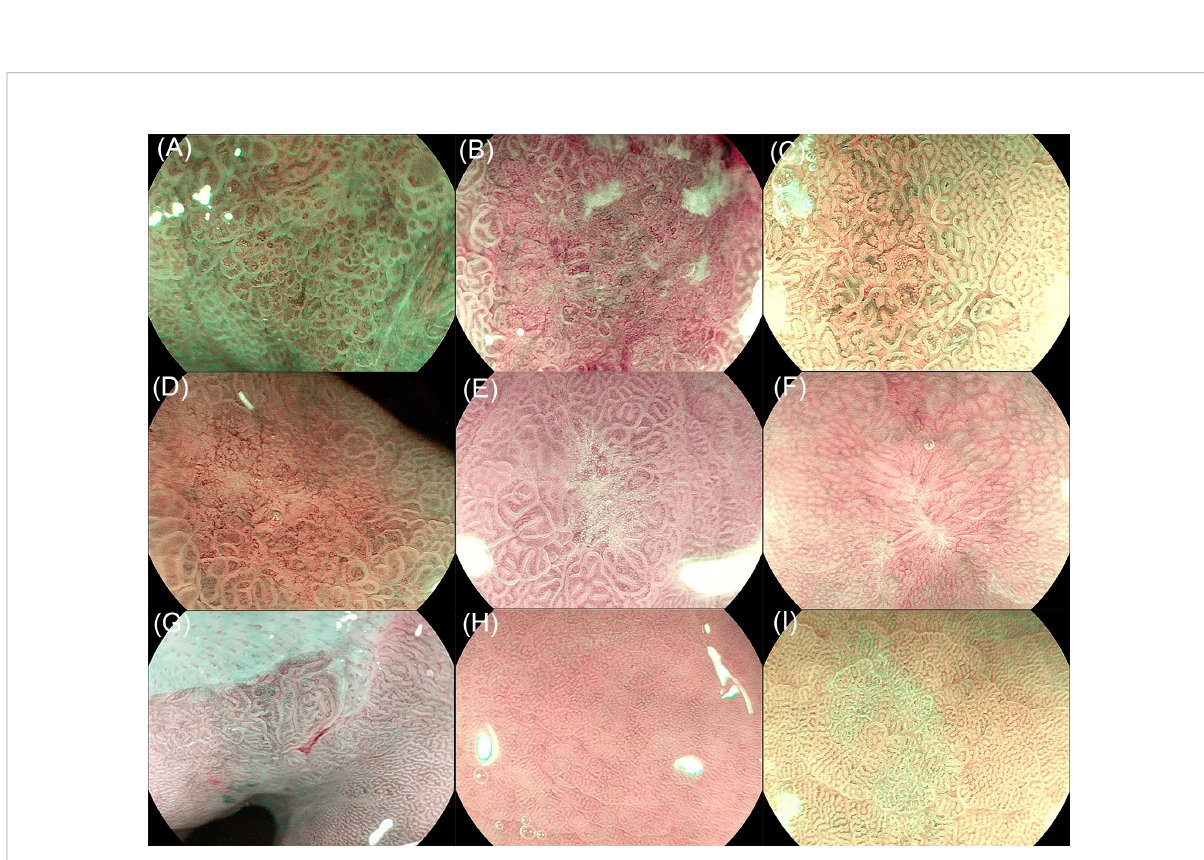
FIGURE 2 Image classi fi cation of the training set. (A) Early gastric cancer (EGC) with a mucosal microsurface pattern (MSP), (B) early gastric cancer (EGC) with microvessel pattern (MVP), (C) localized intestinal metaplasia, (D) localized atrophy, (E) erosion, (F) scaring, (G) cardia gland mucosa, (H) fundic gland mucosa, and (I) pyloric gland